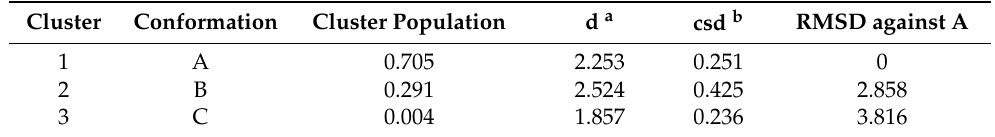
Table 3. Cluster occupancy of RES:11 β -HSD-1 complex through time (1 µ s).